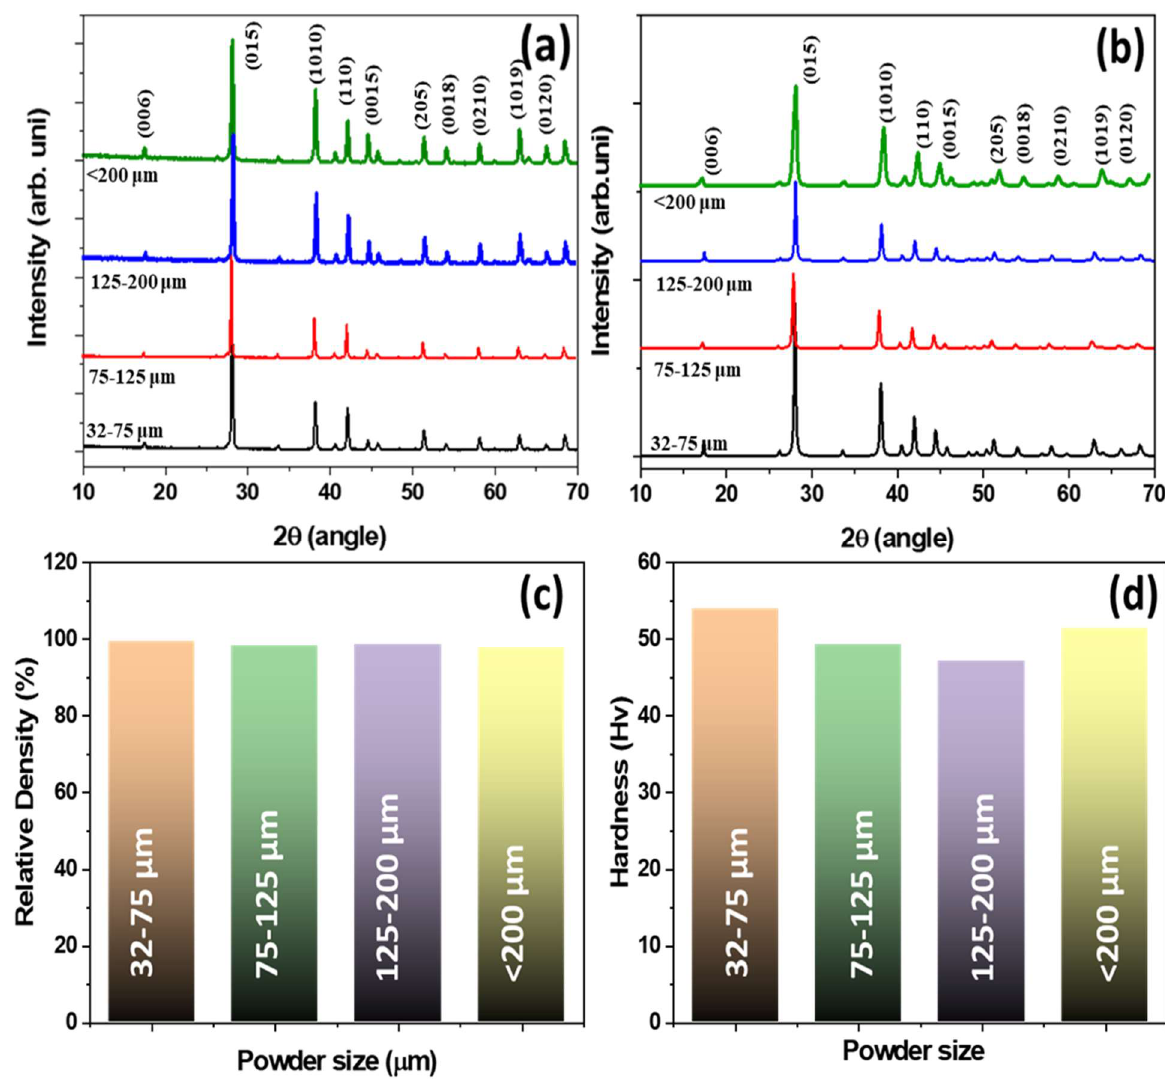
Figure 4. XRD analysis of different sized ( a ) powders and ( b ) bulk specimens of p-type Cu 0.07 Bi 0.5 Sb 1.5 Te 3 alloys. ( c ) relative density measurement and ( d ) micro-Vickers hardness analysis of p-type Cu 0.07 Bi 0.5 Sb 1.5 Te 3 bulk specimens. All of the specimen XRD peaks confirmed the formation of Bi 0.5 Sb 1.5 Te 3 single phase (JCPSD#49-1713). The 32–75 µ m bulk specimen had higher hardness values than other samples, due to its fine grain microstructure.